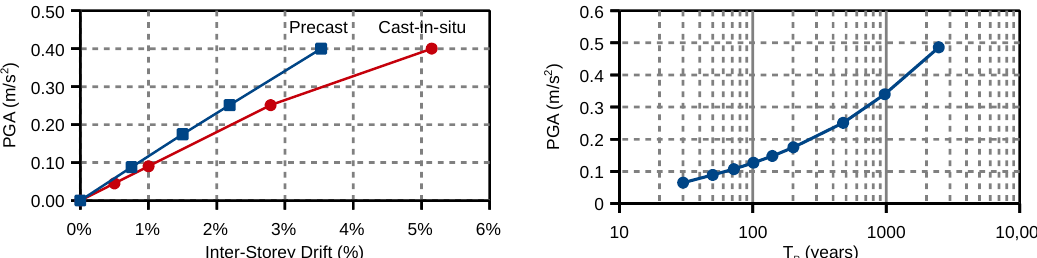
Figure 11. Output of structural analysis: Skeleton curves for precast and cast-in-situ structures ( left ); and Return periods from the seismic map of Barcis ( right